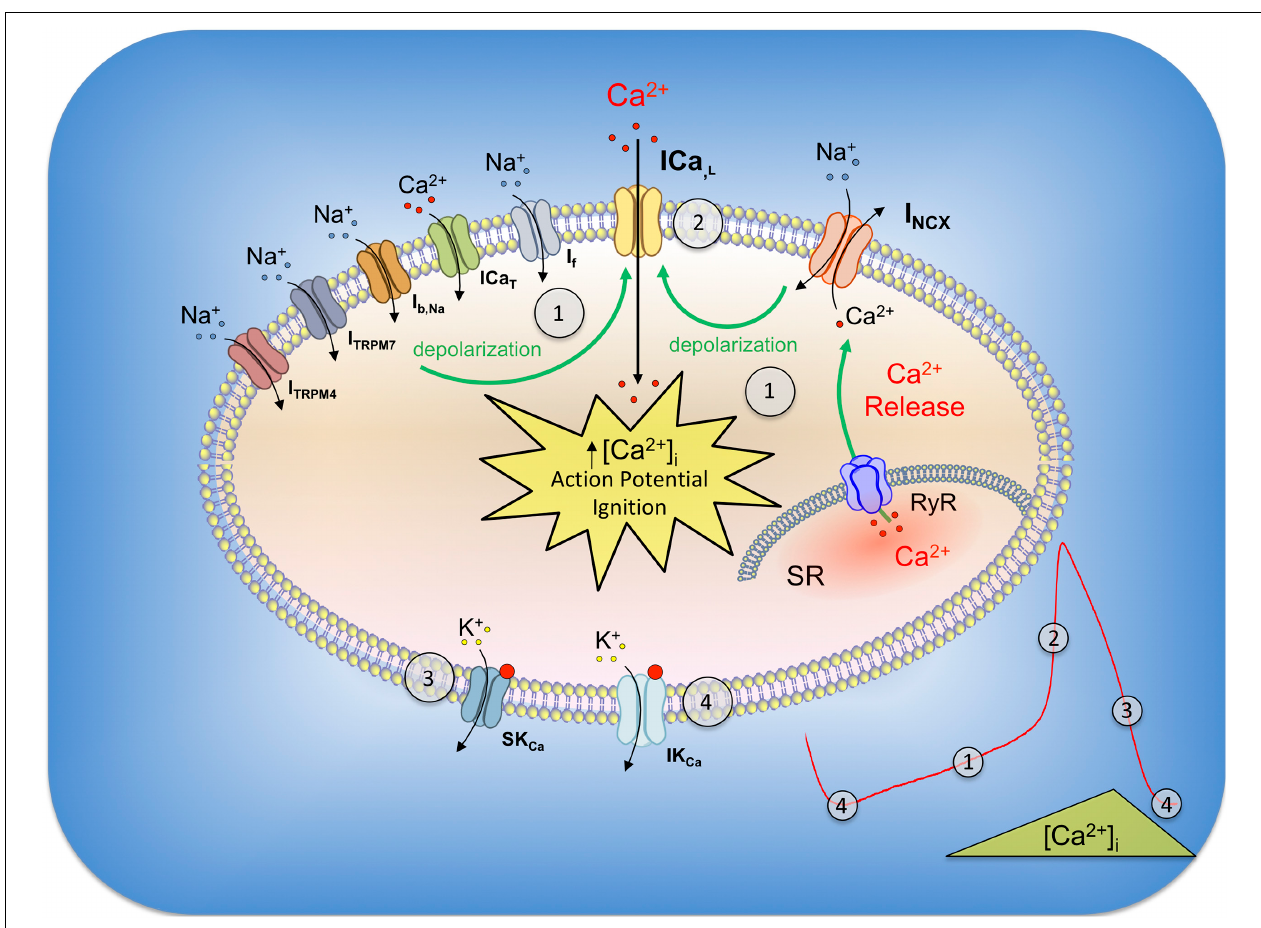
FIGURE 2 | General model of the pacemaker currents in SAN and their relation with SK and IK channels. During the late repolarization of the previous action potential, SK4 are still opened and their outward currents (4) act like a MDP driving force (4), which concurrently activates HCN channels (I f current). The gradual depolarization recruits other conductances such as Ib, Na, ICa T (3.1 and 3.2), ITRPM4 and ITRPM7, which, altogether in synergy, are responsible for the diastolic depolarization (1). In parallel, diastolic sarcoplasmic spontaneous calcium release through RyR receptors increases the cytoplasmic level of calcium and activates the NCX-1 exchanger in its forward mode (1). The progressive Ca 2 + extrusion operated by NCX from early to late DD gradually reduces IKCa and allows inward currents to take over. INCX, together with the other described currents, depolarize the membrane until the threshold of activation for L-type Ca 2 + channels (ICa,L) and AP ignition (2). During the early repolarization, high [Ca 2 + ]i open small SK channels (3) which contribute to this phase of the action potential. The progressive cytosolic decrease of calcium (SR reuptake and extrusion) decreases SK currents at the exception of IKCa due to SK4 higher affinity for Ca 2 + (4). N.B. BKCa, Kv and other conductances have not been included in this cartoon for